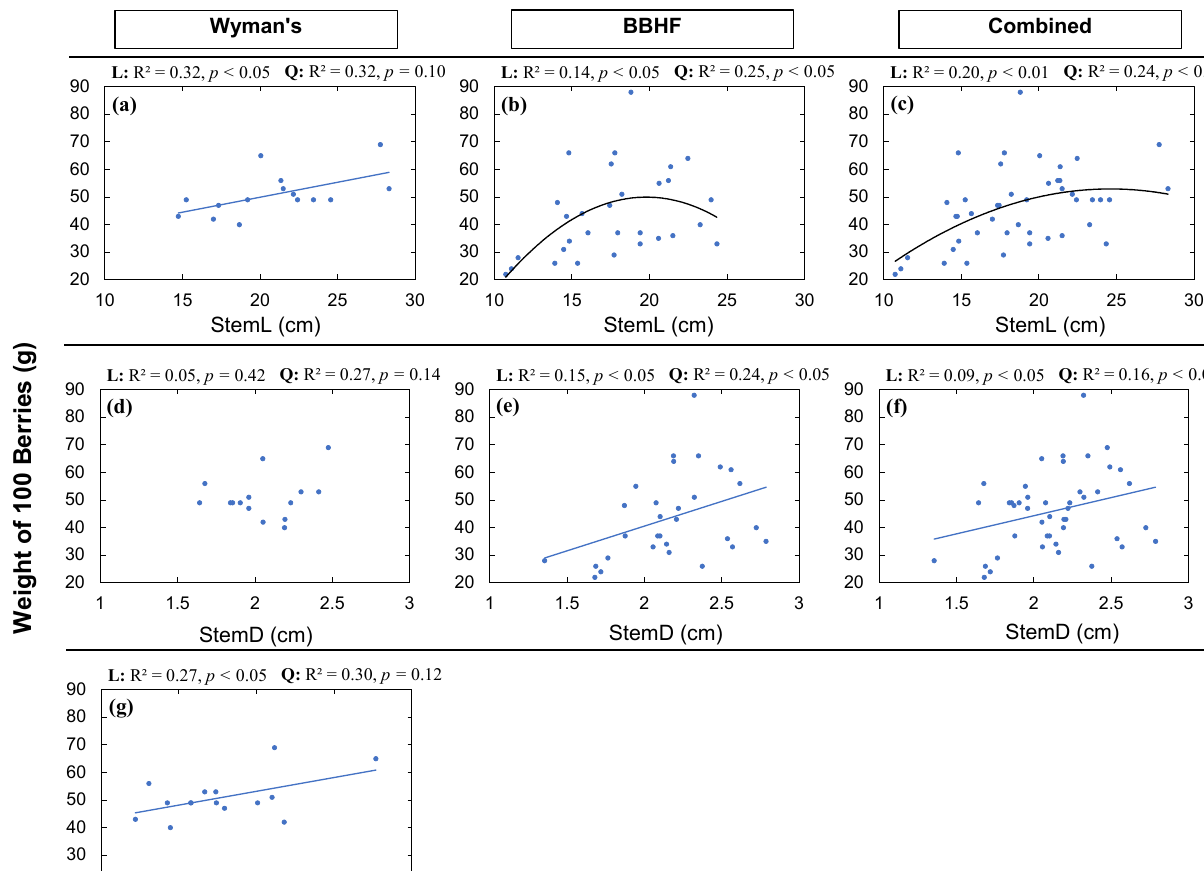
WT (Figure 7a–c), but not for StemD (Figure 7d–f). We found a significant positive linear (Figure 7a: R 2 = 0.32, p < 0.05) and marginally significant quadratic (Figure 7a: R 2 = 0.32, p = 0.10) relationship for WT with StemL among genotypes in the Wyman’s field, whereas for the BBHF field, we found no significant relationships for the BBHF field (Figure 7b) or for the combined data (Figure 7c). We found significant positive linear and quadratic relationships (Figure 7e) for the BBHF field as well as for the combined data of two fields between StemD and WT, but no relationship was found for the Wyman’s field. We also found a significant increase in WT with an increase in SWC (Figure 7g: R 2 = 0.27, p < 0.05).